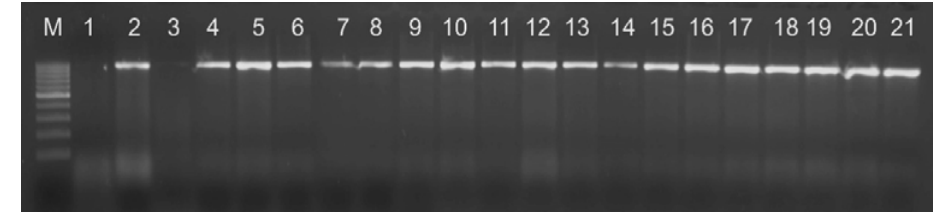
Figure 1. PCR amplification using Pseudomonas genus-specific primers, M: marker. Legend: line 1—negative control, line 2—positive control, lines 3—21: clinical isolates.